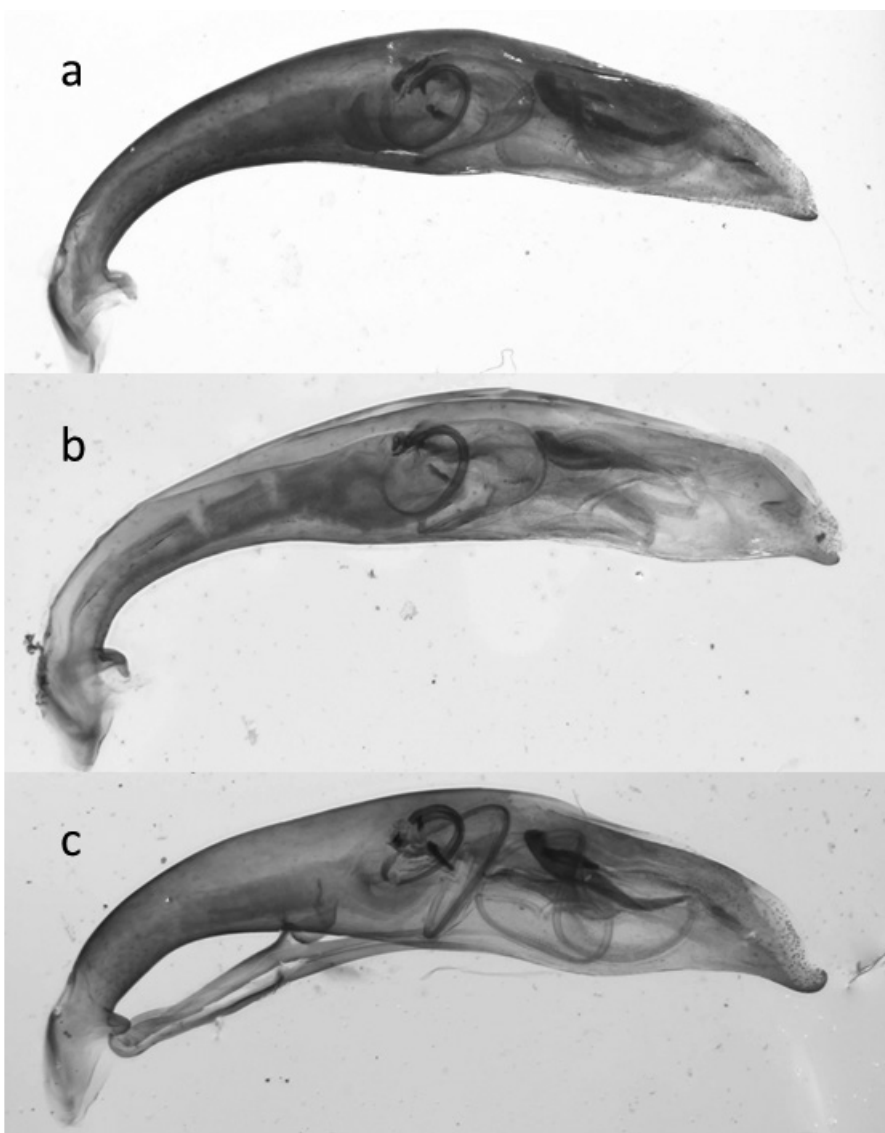
Figure 45. Median lobes of the aedeagus of Lophyridia species: a L. flexuosa b L. hilariola c L. histrio .